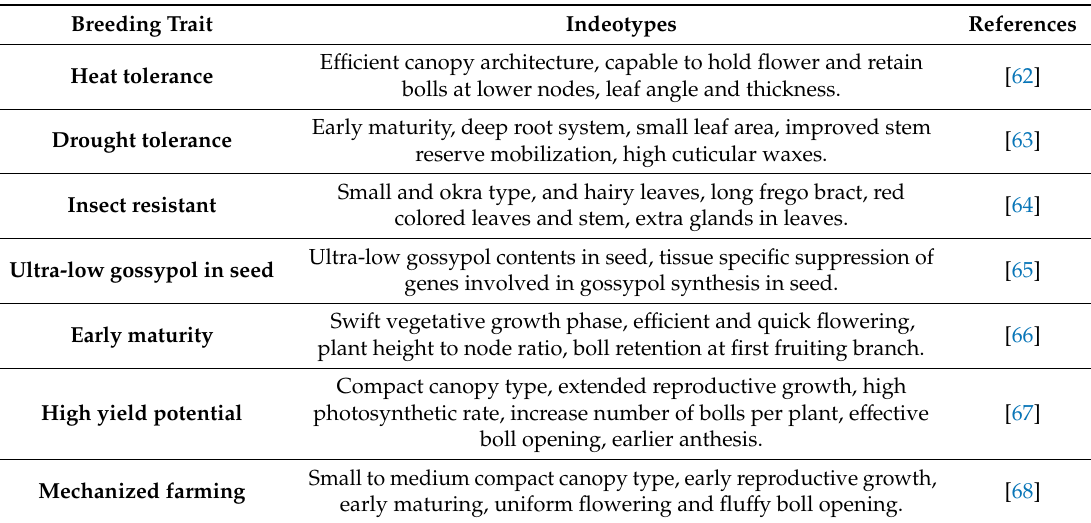
Table 1. Ideotypes of cotton for various breeding